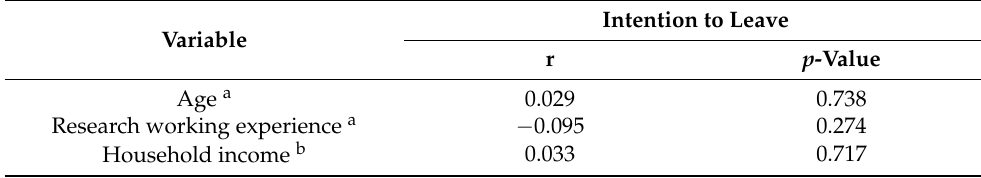
Table 6. The correlation between age, research working experience, and household income with the intention to